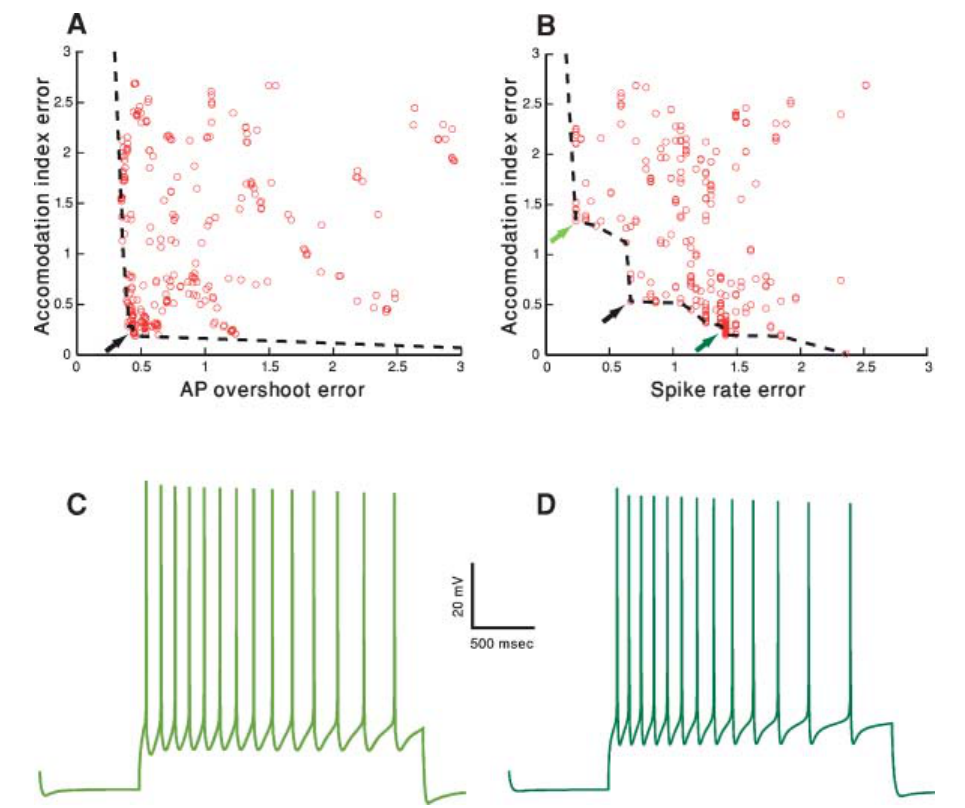
Figure 4. Objective tradeoffs – the pareto fronts . A–D . Fitting of the accommodating neuron displayed in Figure 1A . In both A and B , for each of the 300 parameter sets in the 1000th generation, the final error values (in SD units) of two (out of the total of six) objectives (features) are plotted against each other. Each circle represents the error resulted from a specific parameter set. The set of error values that provided the best trade-offs between the two objectives are connected with a black dashed line (the pareto front, see Methods). Black arrows represent the errors corresponding to the solution depicted in Figures 3B, 3C . (A) AP overshoot versus accommodation index. (B) Accommodation index vs. spike rate. (C) Model response to 150pA, 2seconds depolarization using the error values marked in B by the light green arrow at top left. The values for the channel conductances (in mS/cm 2 ) in this case are: Na t =305; Na p =0.00565; K fast =38; K slow =277; I A =19; Kv3.1=6; Ca=0.00477; SK=49; I h =2; I m =0; Leak soma =0.0044; Leak dendrite =0.001. ( D ) Model response to 150pA, 2seconds depolarization, using the error values marked in B by the dark green arrow at bottom right. The values of the channel conductances (in mS/cm 2 ) in this case are: Na t =389; Na p =0; K fast =29; K slow =175; I A =122; Kv3.1=42; Ca=0.00606; SK=41; I h =9; I m =0; Leak soma =0.0034; Leak dendrite =0.001.